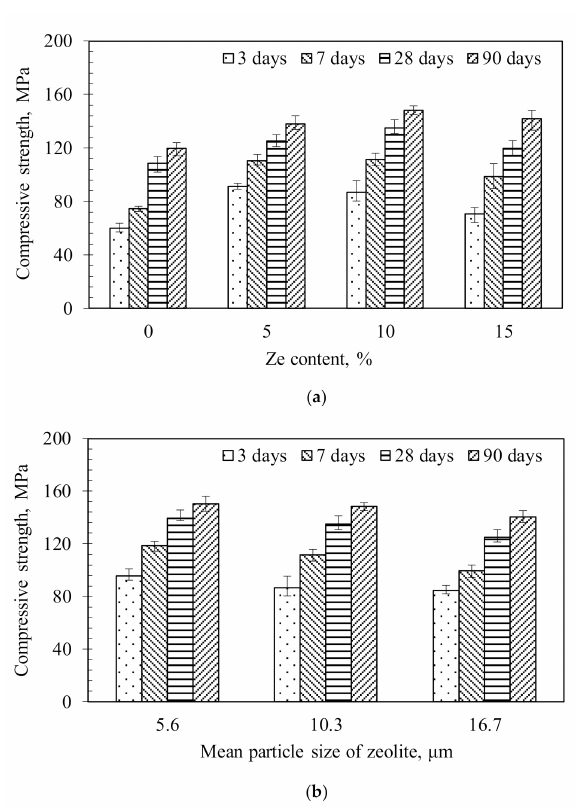
Figure 7. E ff ect of the zeolite content ( a ) and the particle size of zeolite ( b ) on the compressive strength of HPC specimens—tests were performed on 3 replicates.